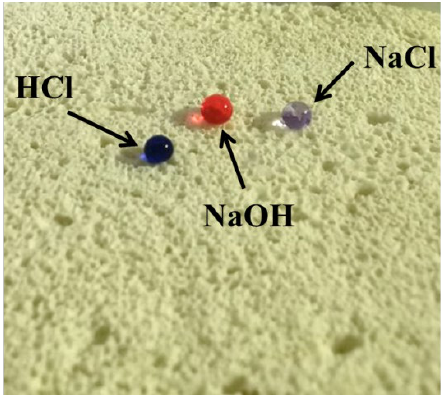
Figure 11. The influence of different mechanical polishing thickness on the water contact angle of F-MOC.